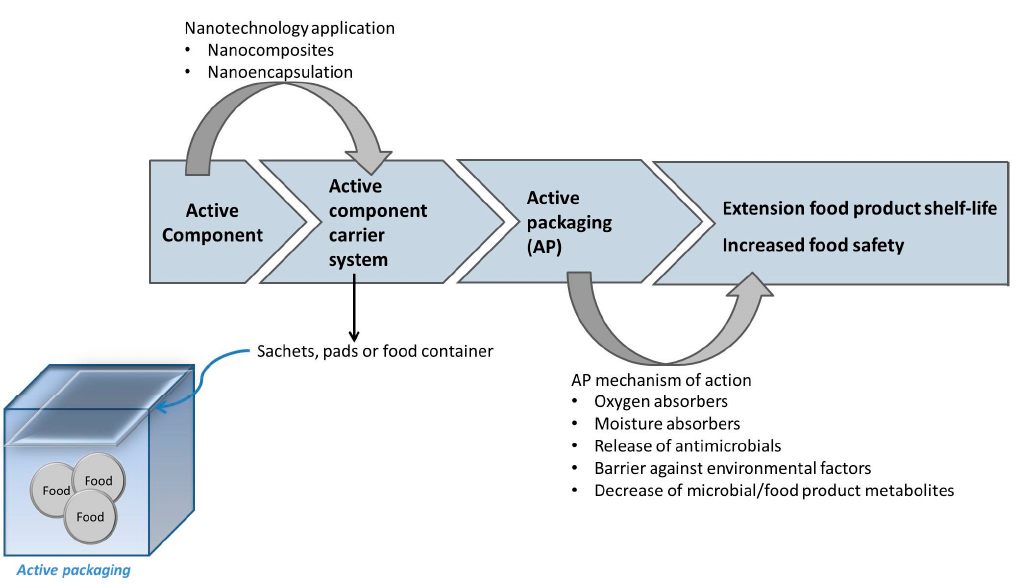
Figure 1. Application of nanotechnology and mechanism of action of active packaging in extending bread and GF bread shelf-life, and increasing food safety.